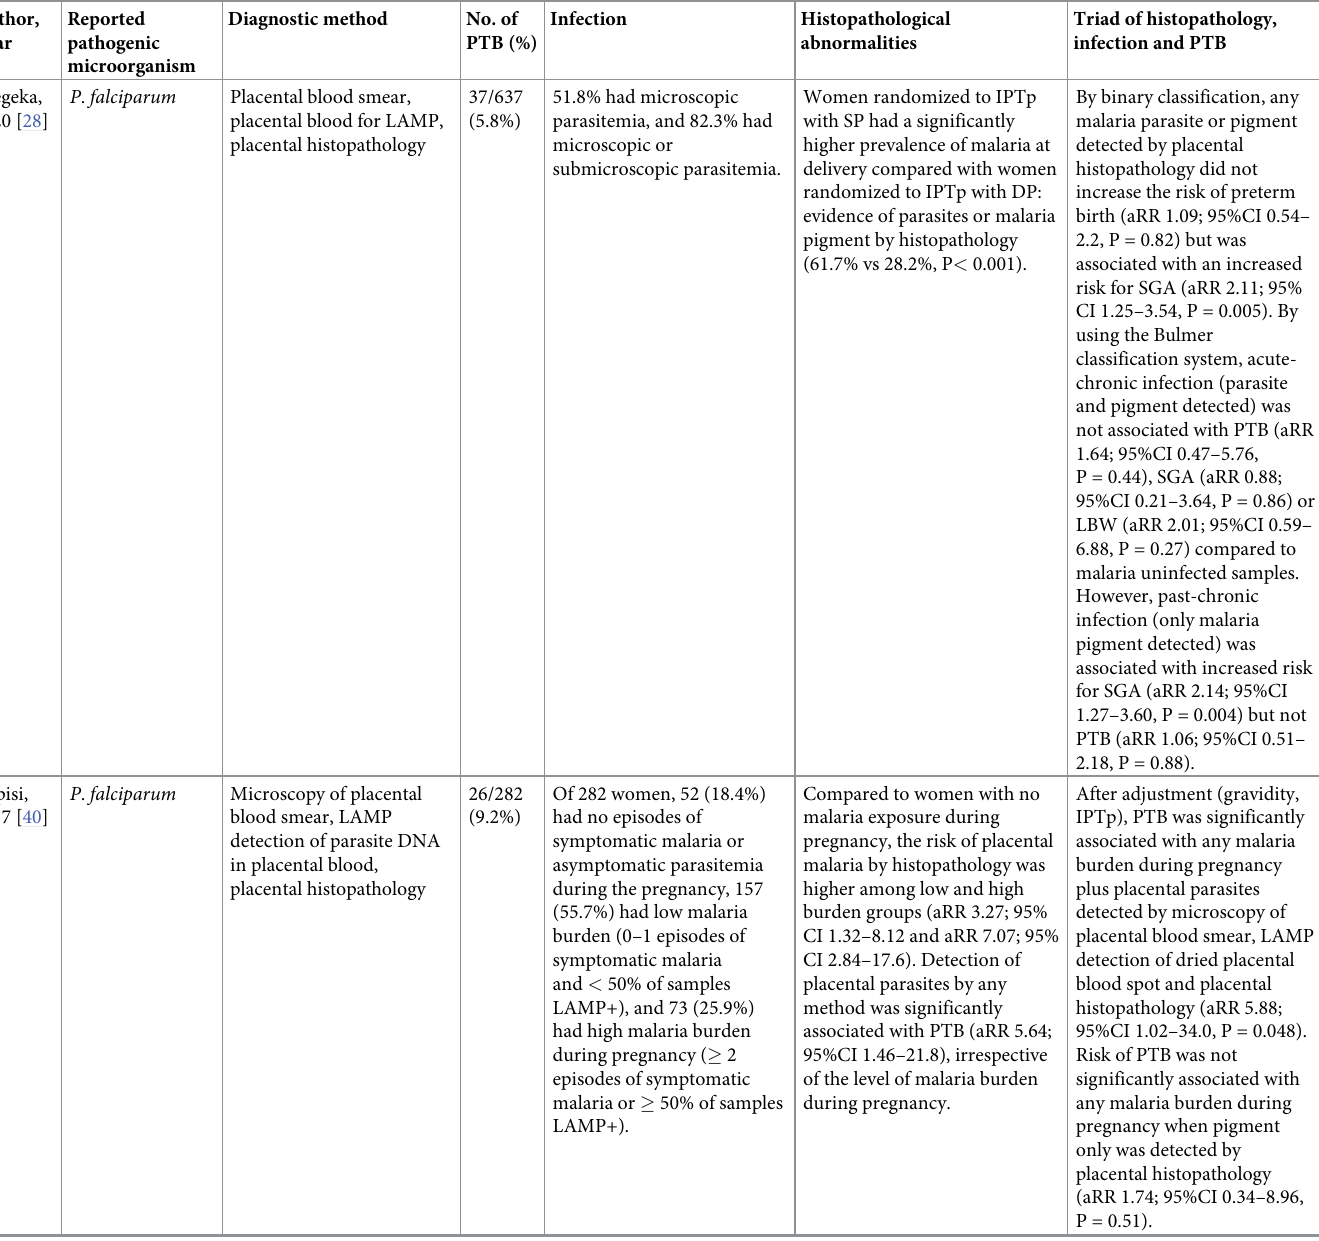
Table 4. Identified parasitic infection and histopathological changes in preterm